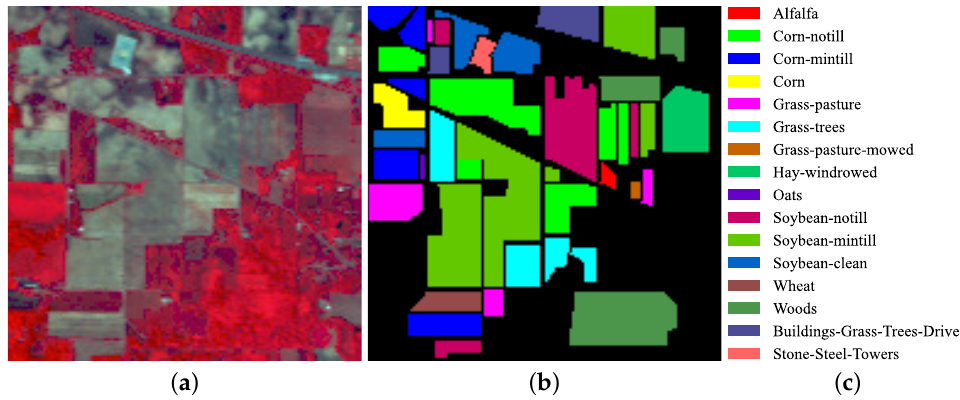
Figure 4. False color image and ground truth image of the IP dataset. ( a ) False color image. ( b ) ground truth image. ( c ) Color coding for each category.